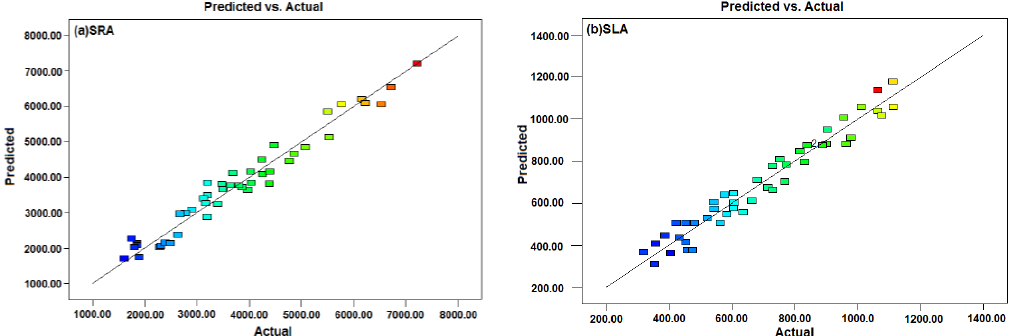
Figure 9. Predicted stimulated area vs. the actual stimulated area: ( a ) The predicted area vs. the actural area for SRA; and ( b ) The predicted area vs. the actural area for SLA.